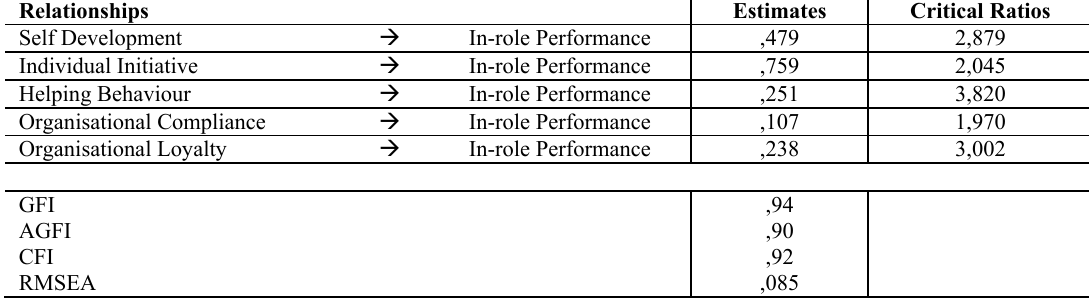
Table 4: Extra-role/In-role Performance – Estimates, Critical Ratios, and Goodness-of-Fit